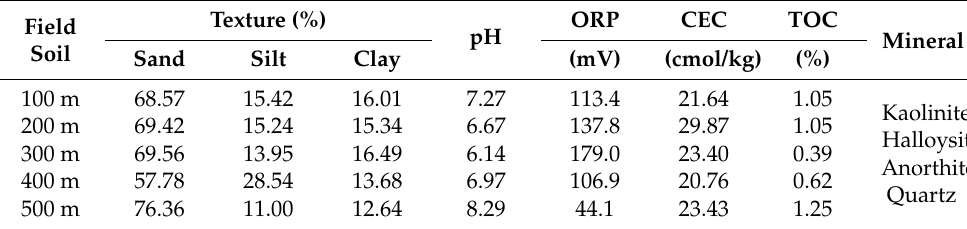
Table 2. Soil characterization of field soil (contaminated